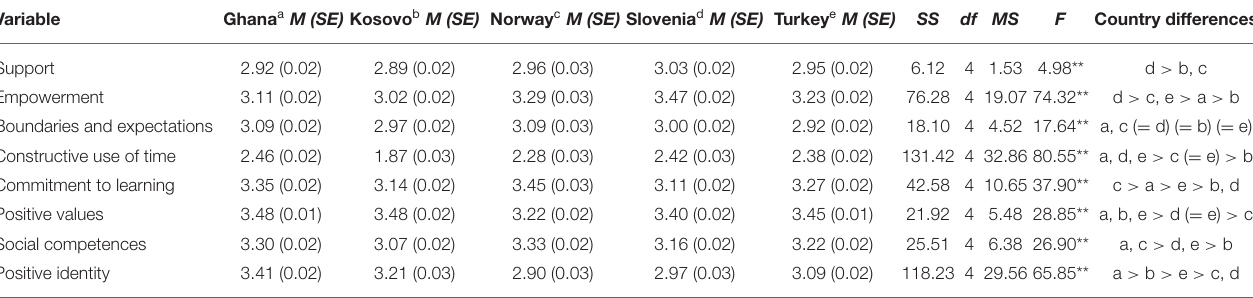
TABLE 5 | Developmental assets by Country: MANCOVA. Variable